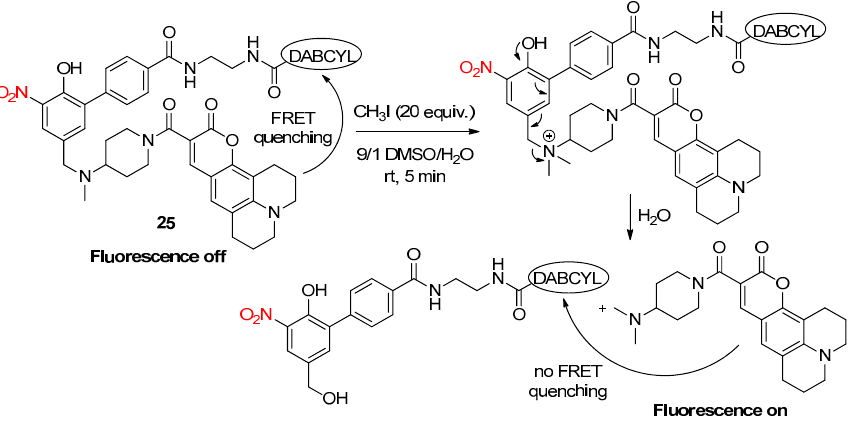
Scheme 28. Mechanism of FRET probe 25 activation for the detection of alkylating agents.